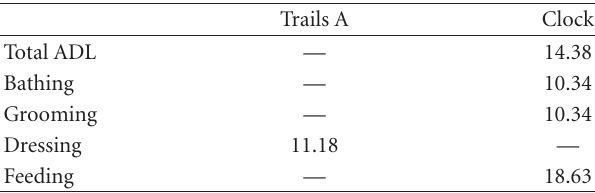
Table 2: t values of significant predictors of IADLs in men and women.